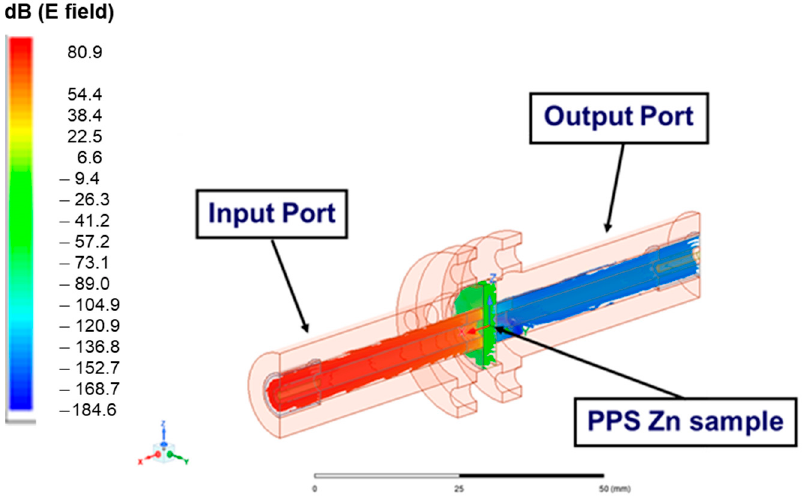
Figure 10. E- fi eld for the PPS zinc